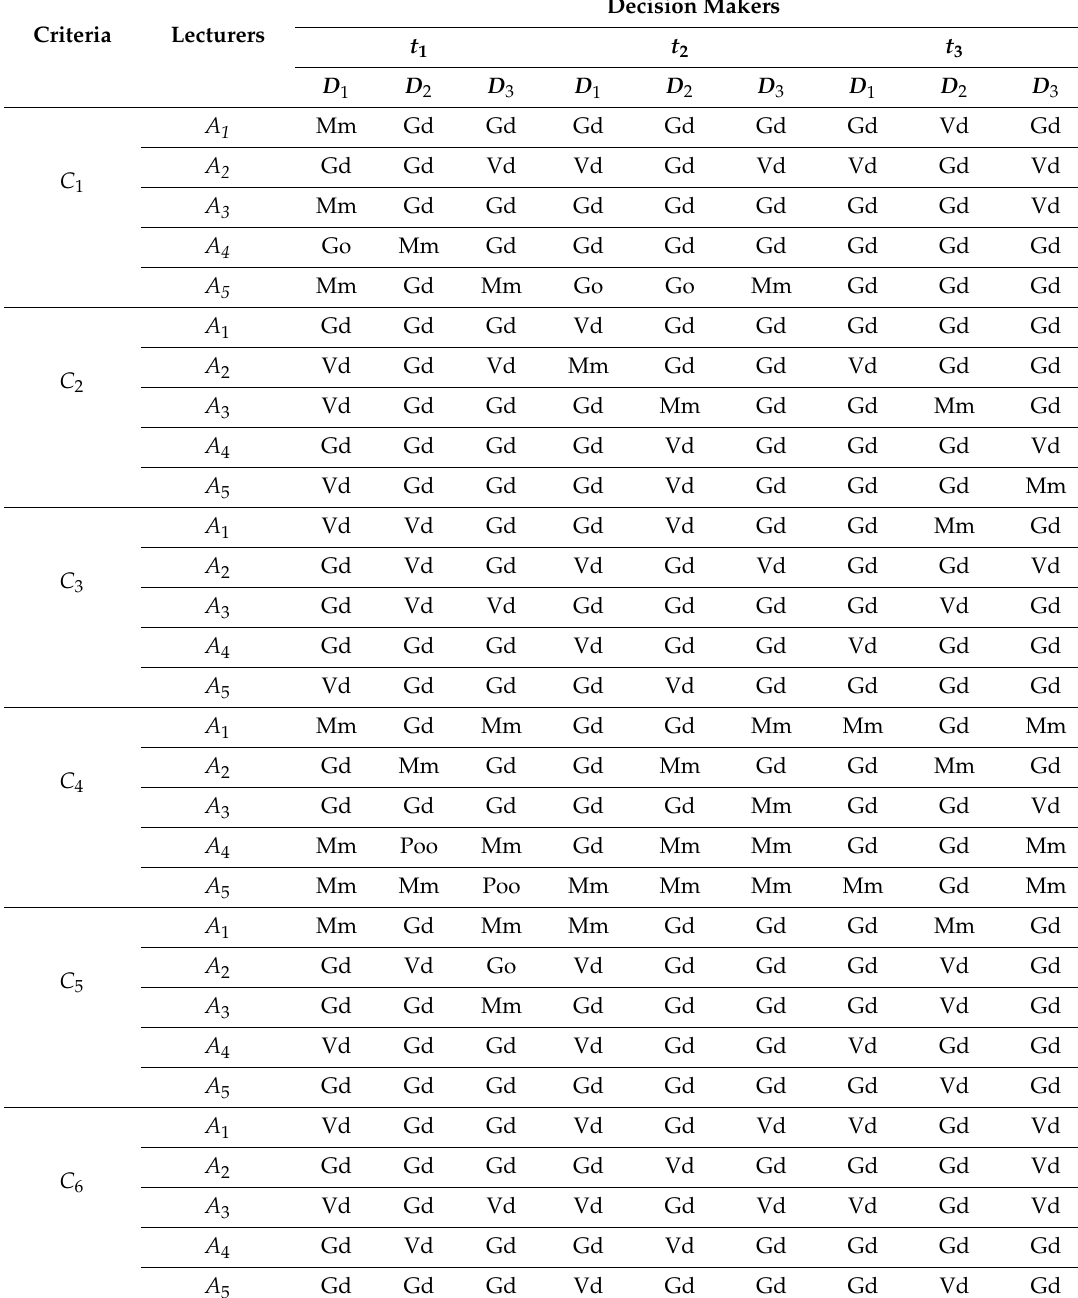
Table 2. Dynamic interval-valued neutrosophic decision matrix.